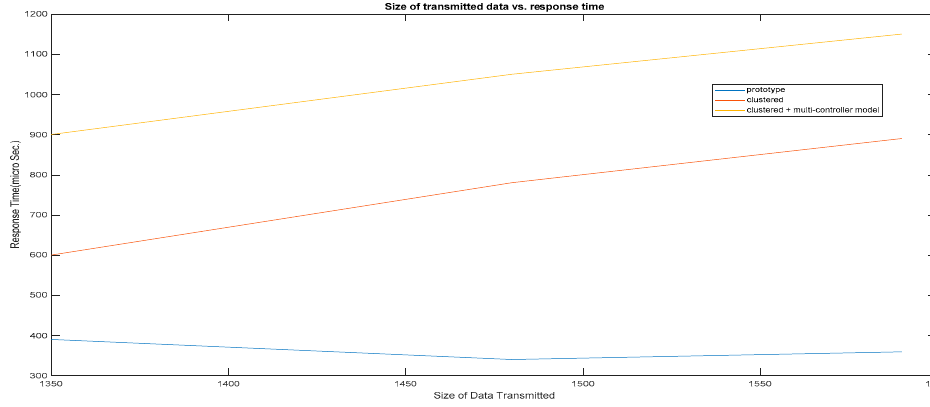
Energies 2022 , 15 , x FOR PEER REVIEW Figure 17. Relationship between response time and the quantity of packets. Figure 17. Relationship between response time and the quantity of packets. Figure 17. Relationship between response time and the quantity of packets.